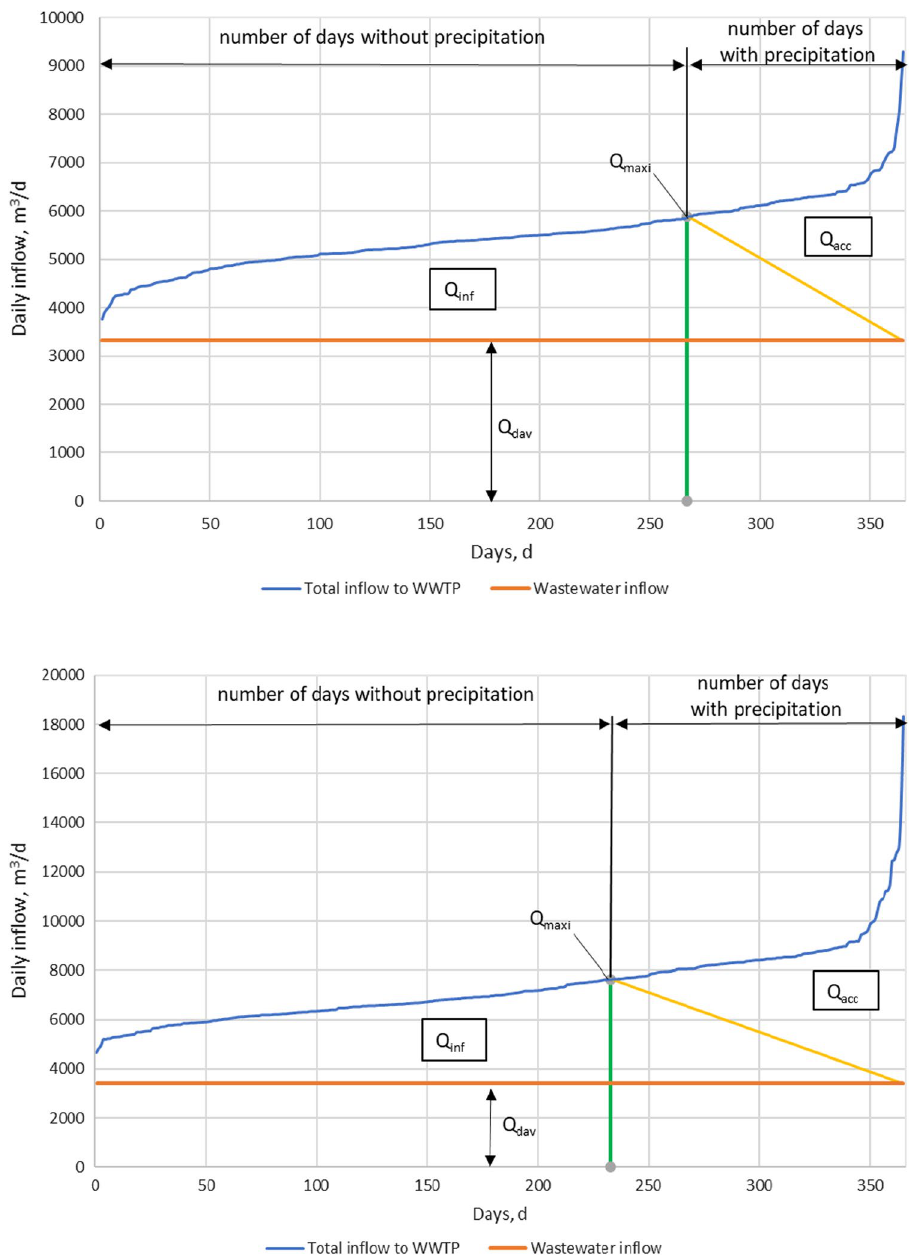
Fig. 4 Volumes of infiltration and accidental water inflow to WWTP in 2016 determined using the triangle method